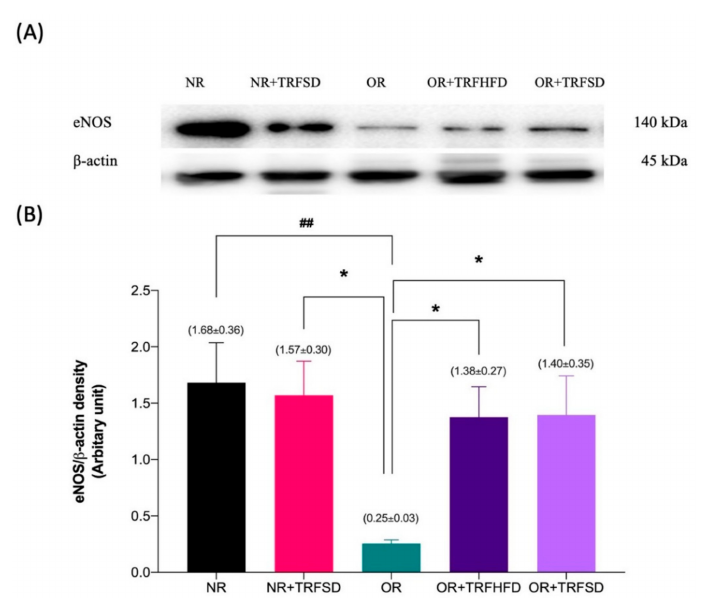
Figure 5. Immunoblot analysis of eNOS protein expression in the thoracic aorta: ( A ) Representative immunoblot blot showing the expression of eNOS protein or NR, NR + TRFSD, OR, OR + TRFHFD, and OR + TRFSD groups; ( B ) Graphical representation of the data, normalized to β -actin. Data are presented as mean ± SEM ( n = 7). ## p < 0.01 vs. NR. * p < 0.05 vs. OR.